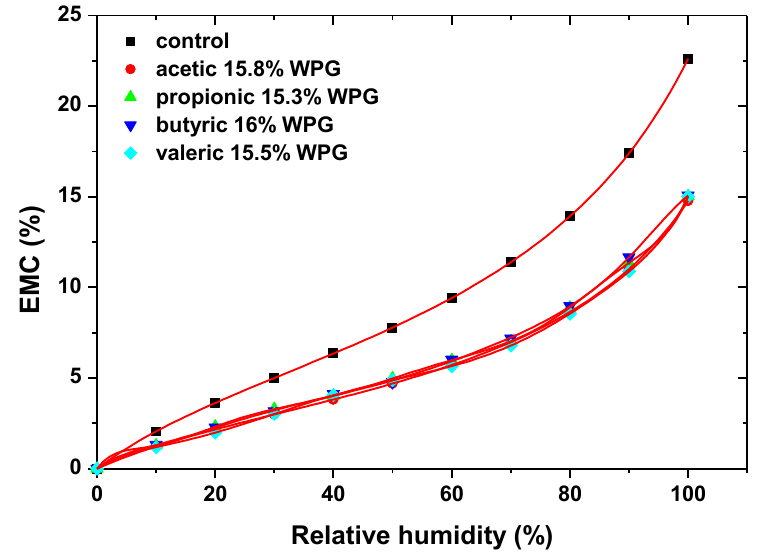
Figure 2. The adsorption isotherms for pine wood: control ( ■ ); acetic 15.8% WPG-weight percent gain), (●); propionic 15.3% WPG ( ▲ ); butyric 16% WPG ( ▼ ); and valeric 15.5% WPG ( ◆ ) [21].